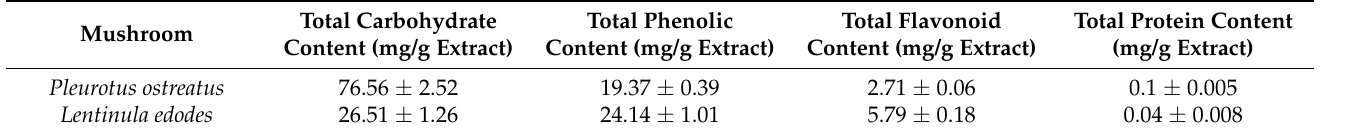
Table 1. Total bioactive compounds in Pleurotus ostreatus and Lentinula edodes .